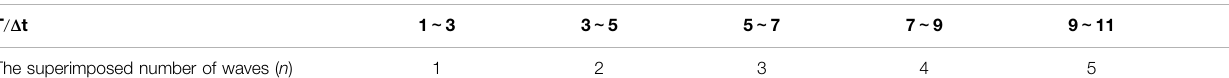
TABLE 1 | Relationship between the duration of landslides and the superimposed number of waves.